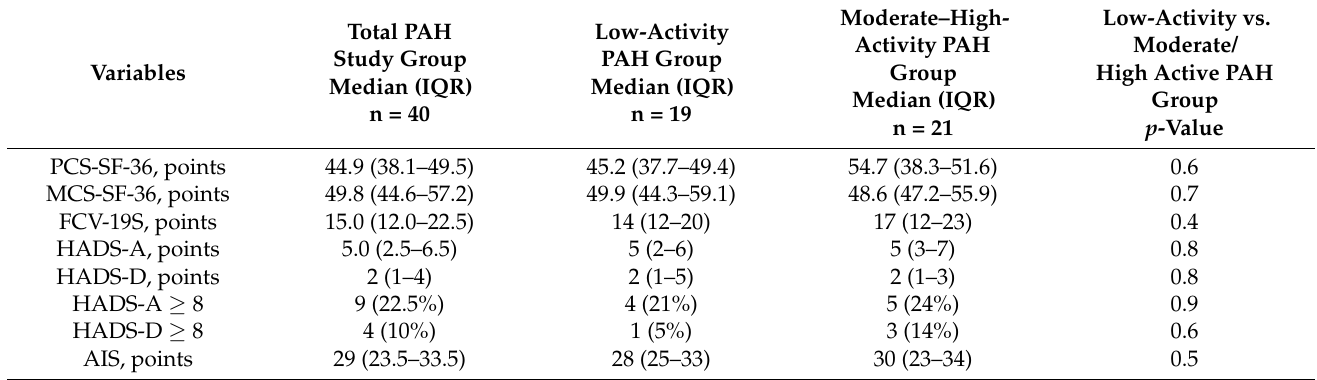
Table 3. Quality of life, fear of COVID-19, hospital anxiety and depression, acceptance of the illness among low-activity and moderate–high-activity PAH